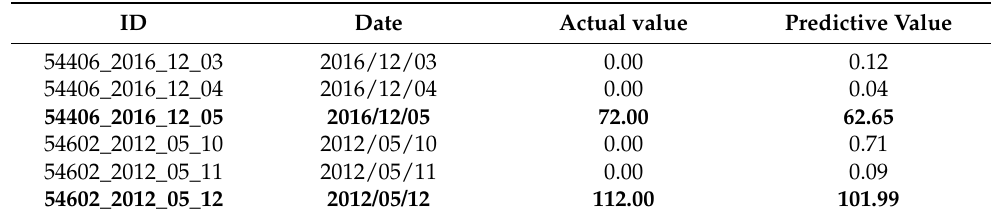
Table 5. Forecast of extreme rainfall. The bolded fields emphasize that extreme rainstorms occurred on that day.